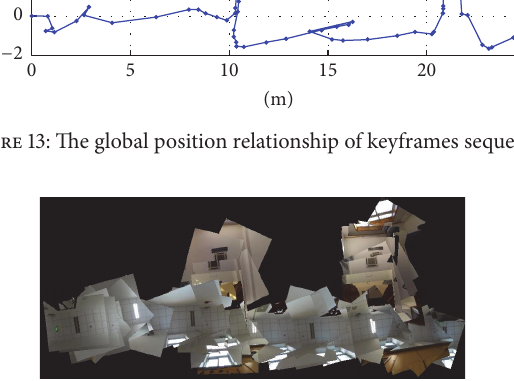
Figure 14: Indoor environment described by keyframes sequence.